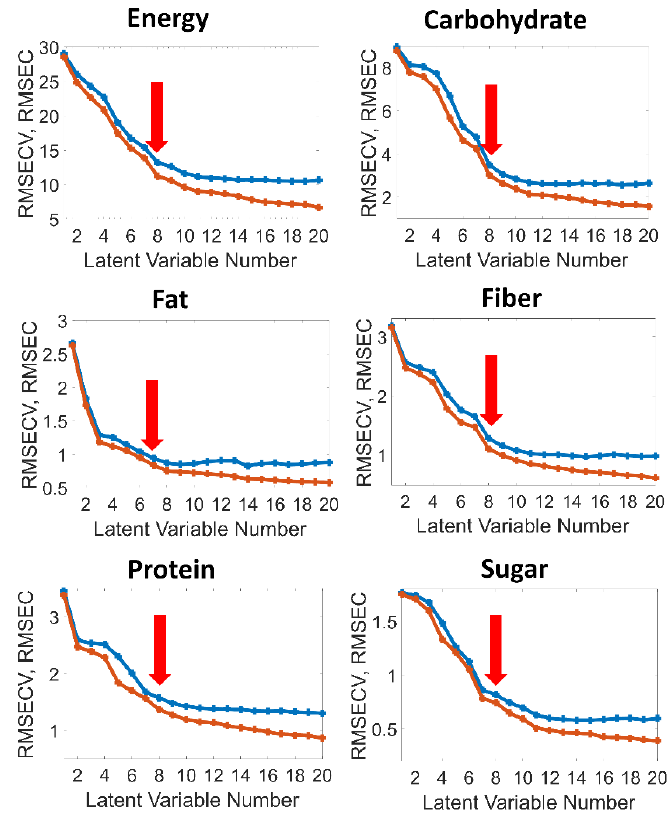
Figure 4. RMSEC (red) and RMSECV (blue) versus the latent variable number for the individual calibrations of the nutritional parameters.